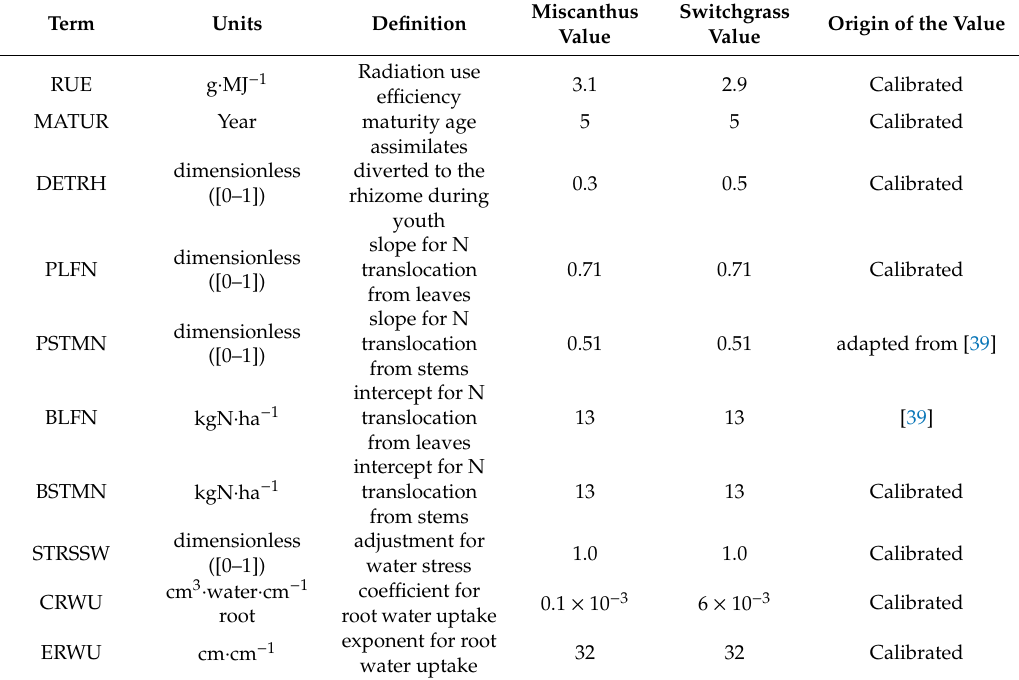
Table A1. Model parameter settings and calibrated values for miscanthus and